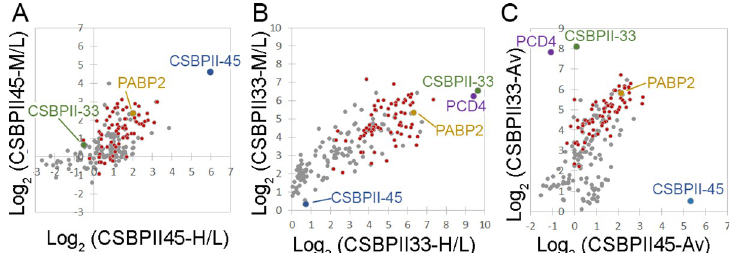
Fig 10. Immunoprecipitation of the T . brucei CSBPII complex proteins. A. IP of HA- Tb CSBPII-45 with anti-HA beads from SILAC labelled cells (M or H) versus parental cells (L), biological replicates with label swap. B. IP of HA- Tb CSBPII-33 with anti-HA beads from SILAC labelled cells (M or H) versus parental cells (L), biological replicates with label swap. C. Comparison of IP with HA- Tb CSBPII-33 and HA- Tb CSBPII-45 using averaged SILAC ratios from biological replicates. Grey–proteins identified in both replicates, Red–ribosomal proteins, Blue— Tb CSBPII-45, Green– Tb CSBPII-33, Purple–PCD4,